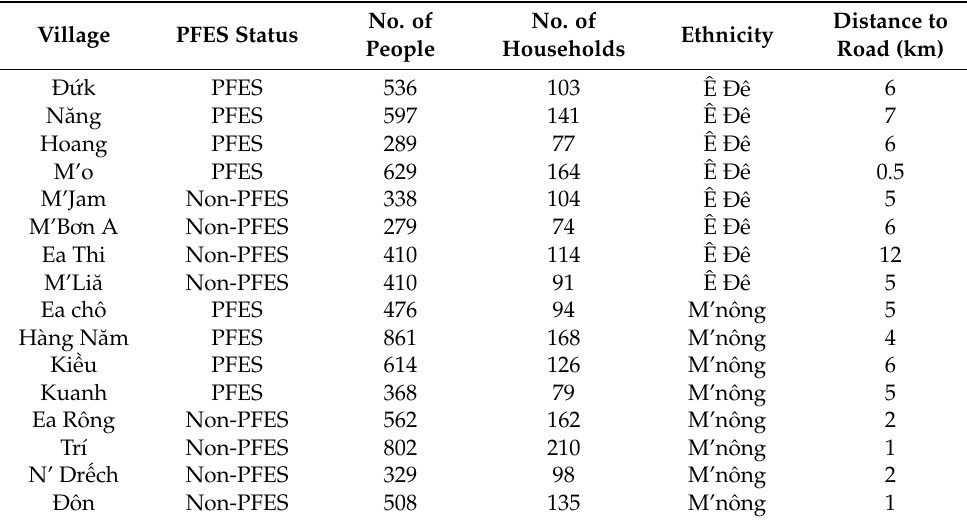
Table 2. Background information about the study